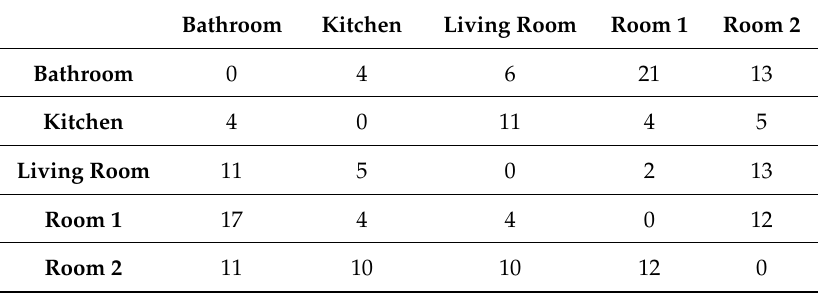
Table 4. Confusion matrix of transitions for CASAS using wide-area sensors.